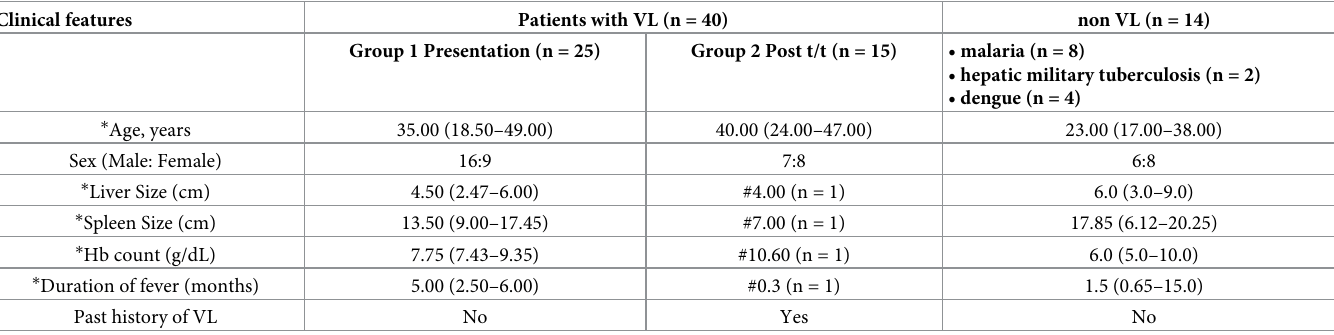
Table 1. Study population to assess the performance of qPCR vs. RPA in cases of VL. Clinical